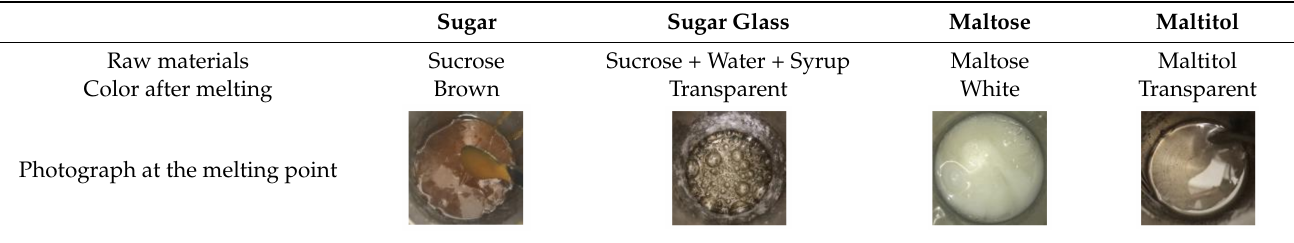
Table 1. Characteristics of various